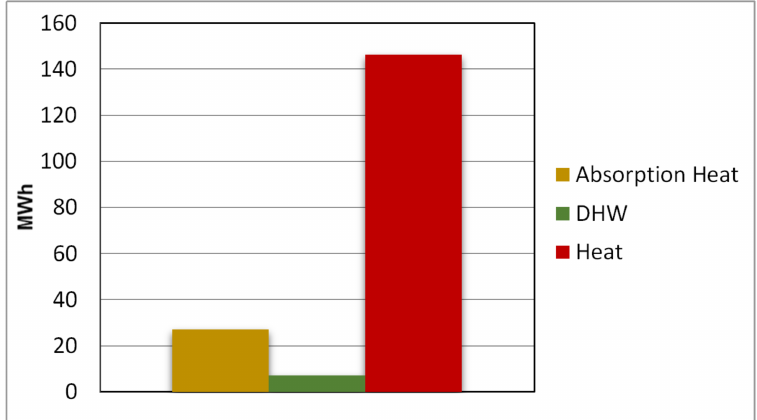
Figure 13. Distribution of biomass heat